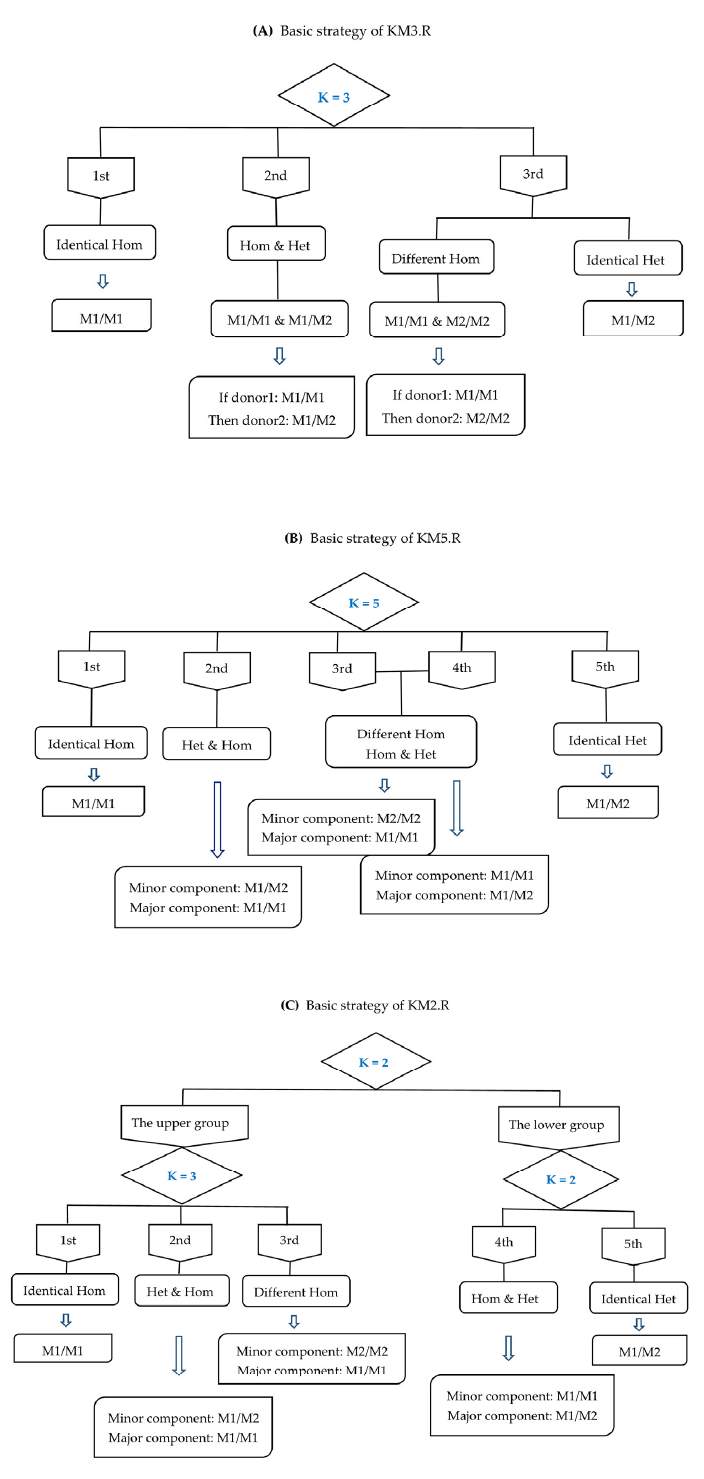
Figure 3. Flow charts of the basic strategies utilized for deconvolution. ( A – C ) represent the KM3.R, KM5.R, and KM2.R scripts, respectively. Based on the strategies, the scripts were further optimized to effectively deconvolve the incorrectly clustered loci. The value of K indicates the number of clusters needed for the dataset consisting of the F MAR values of different loci. In the KM2.R script, the F MAR values were preliminarily clustered into two groups labeled “the upper group” and “the lower group”. Then, the upper group was clustered into three categories labeled 1st, 2nd, and 3rd, and the lower group was clustered into two categories labeled 4th and 5th. Note that the meanings of M1 and M2 in the figures are the same as those in Table